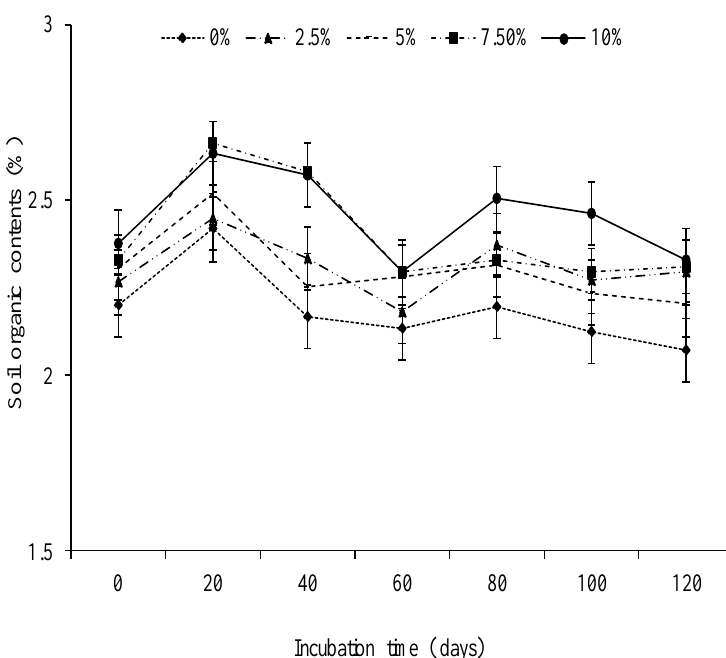
Figure 3 . Soil organic carbon fluctuations during incubation of a Hutton soil amended with different biochar rates. Error bars indicate SD.